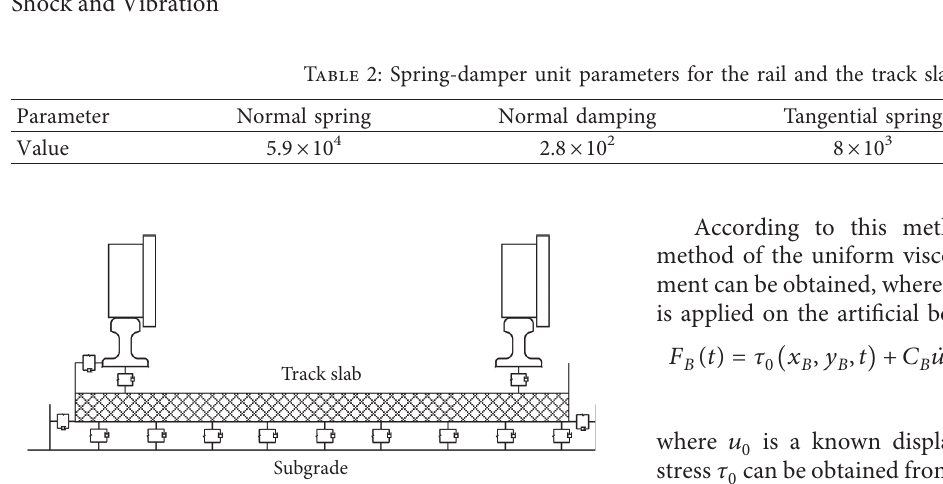
Figure 7: Spring-damper unit between the track slab and the